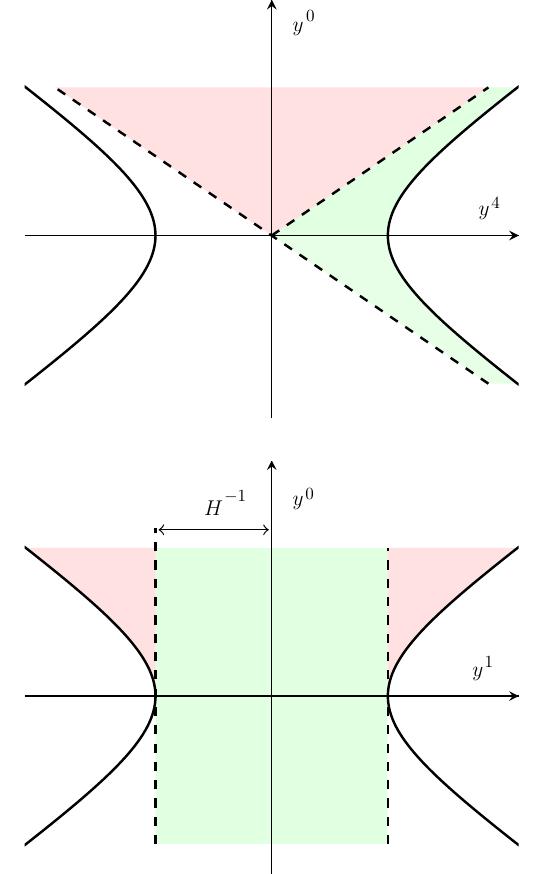
Fig. 2 Projection of the 2-dimensional de Sitter space, − ( y 0 ) 2 + ( y 1 ) 2 + ( y 4 ) 2 = H − 2 , as covered by the expanding FLRW coordinates (17)denotedwithblueonthe ( y 4 , y 0 ) -plane(top)andthe ( y 1 , y 0 ) -plane (bottom)